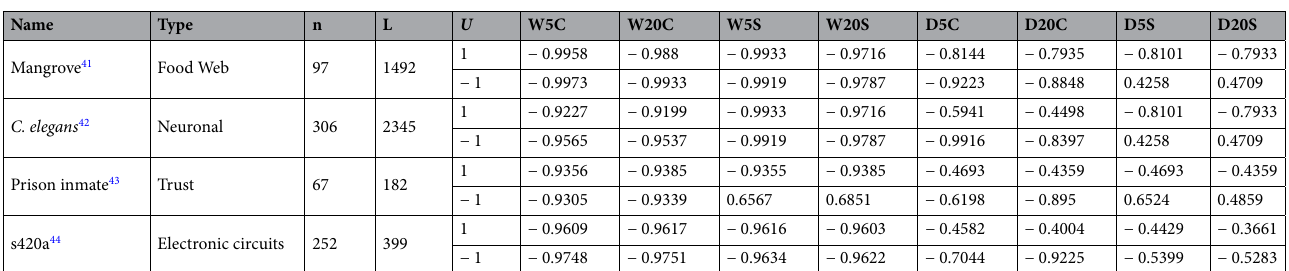
Table 1. The table shows the Pearson correlation coefficient between f (the strength of internal network fluxes) and g (the degree of the effectiveness of external signals) in different measurement modes, when input signals of different sizes are applied. Definition of parameters: n is the number of nodes, L is the number of edges, U is the input signal applied to the network, which is considered to be 1 or − 1. The correlation coefficient between f and g is calculated in different settings as follows. including The input signal is applied to (W5C) all nodes in 5 Consecutive steps, (W20C) to all nodes in 20 Consecutive steps, (W5S) all nodes and the signal is applied at the first step and there are not any signals in the next 4 steps, (W20S) all nodes and the signal is applied at the first step and there are not any signals in the next 19 steps (D5C) the driver nodes in 5 Consecutive steps, (D20C) the driver nodes in 20 Consecutive steps, (D5S) the driver nodes and the signal is applied at the first step and there are not any signals in the next 4 steps, and (D20S) the driver nodes and the signal is applied at the first step and there are not any signals in the next 19